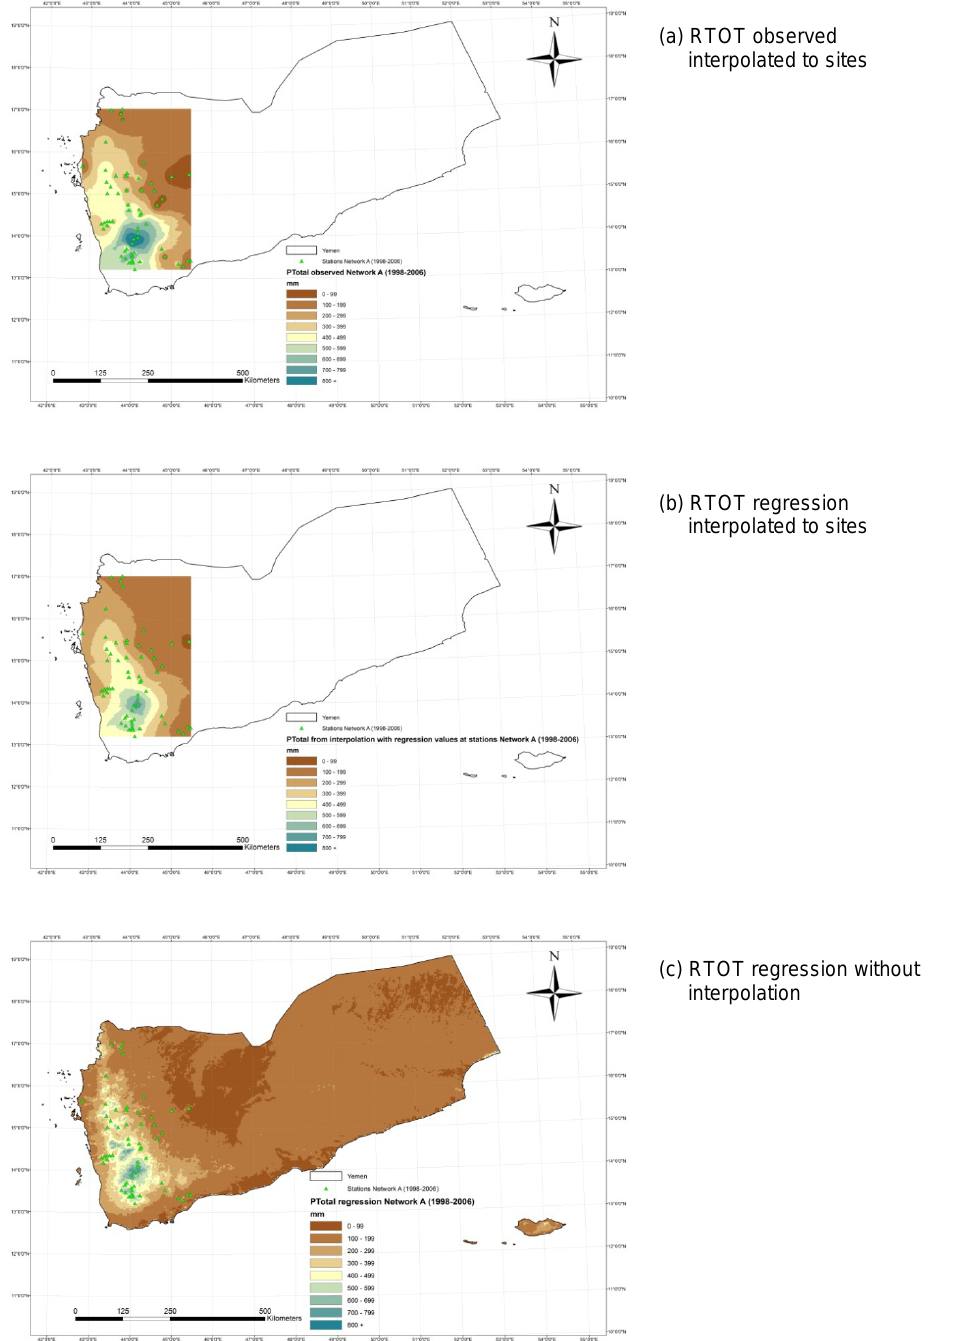
Figure 11 Observed and estimated mean annual precipitation (RTOT) based on Network A